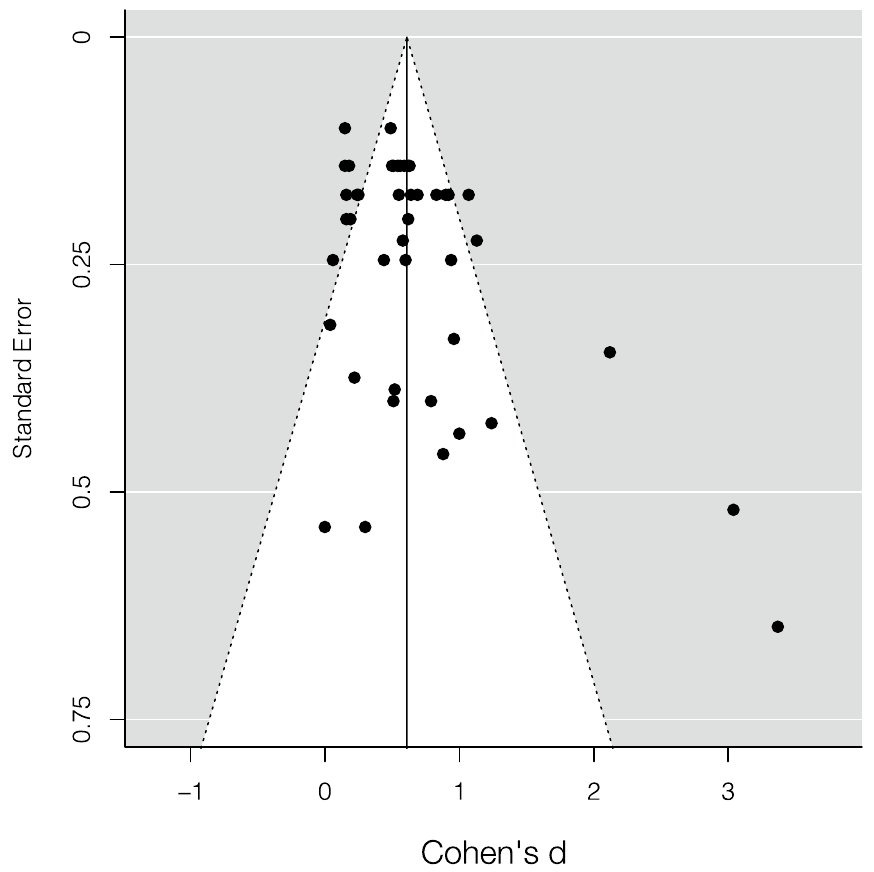
Figure 3. Funnel plot of the studies that used accuracy as main dependent variable included in the meta- analysis. Black dots represent the studies included. The vertical line represents the corrected effect size.